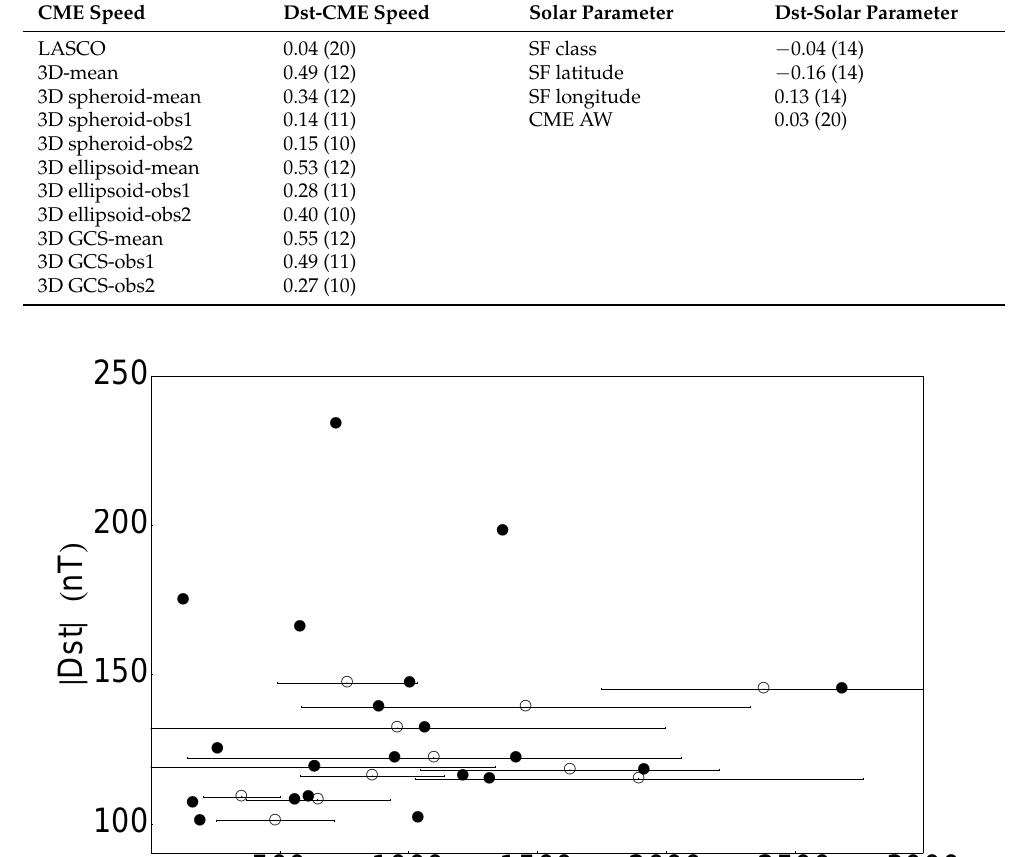
Table 4. Table of Pearson correlation coefficients between GS Dst index, CME speed and other solar parameters. The sample size is given in parentheses.